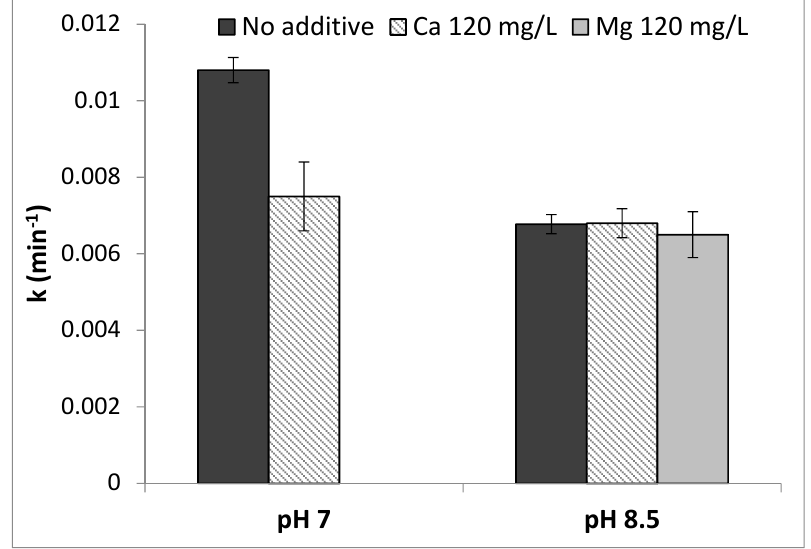
Figure 2. CBZ degradation by N-doped TiO 2 -coated Al 2 O 3 membranes, without (no additive) and with addition of 120 mg/L Ca 2+ (pH 7 and 8.5) and 120 mg/L Mg 2+ (pH 8.5).